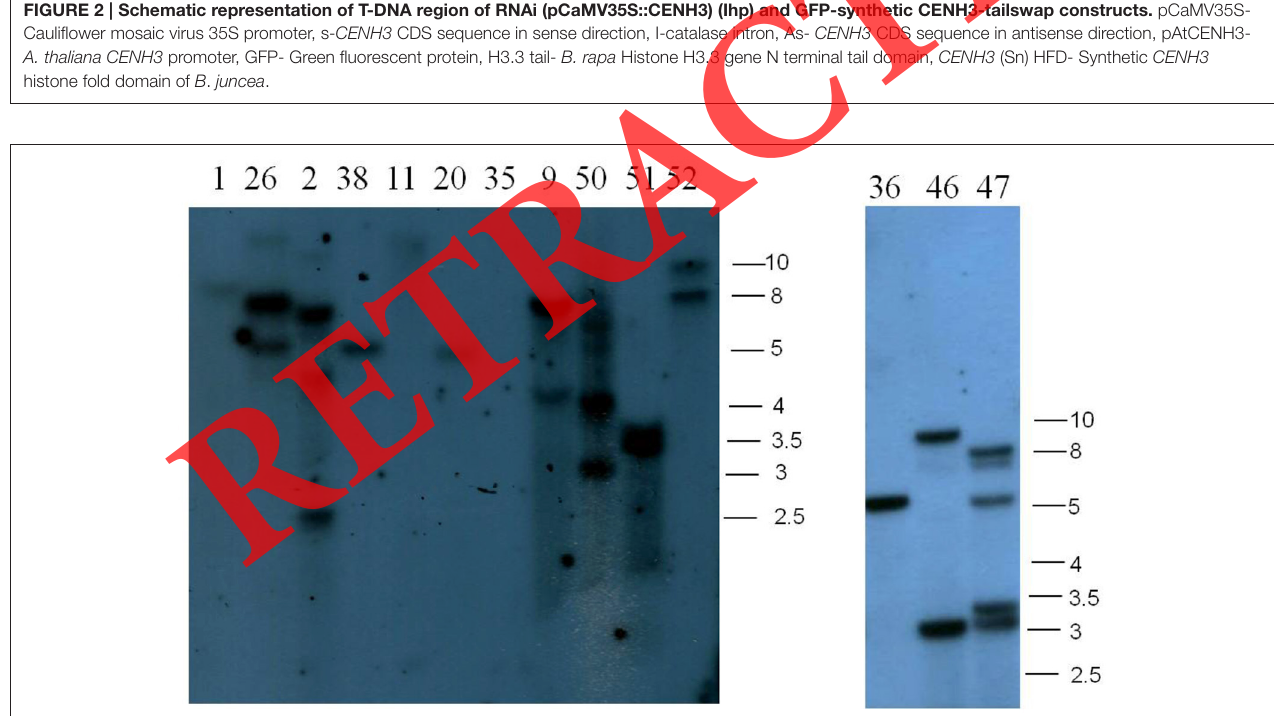
synthetic CENH3 reverse primers (Supplementary Table 1).